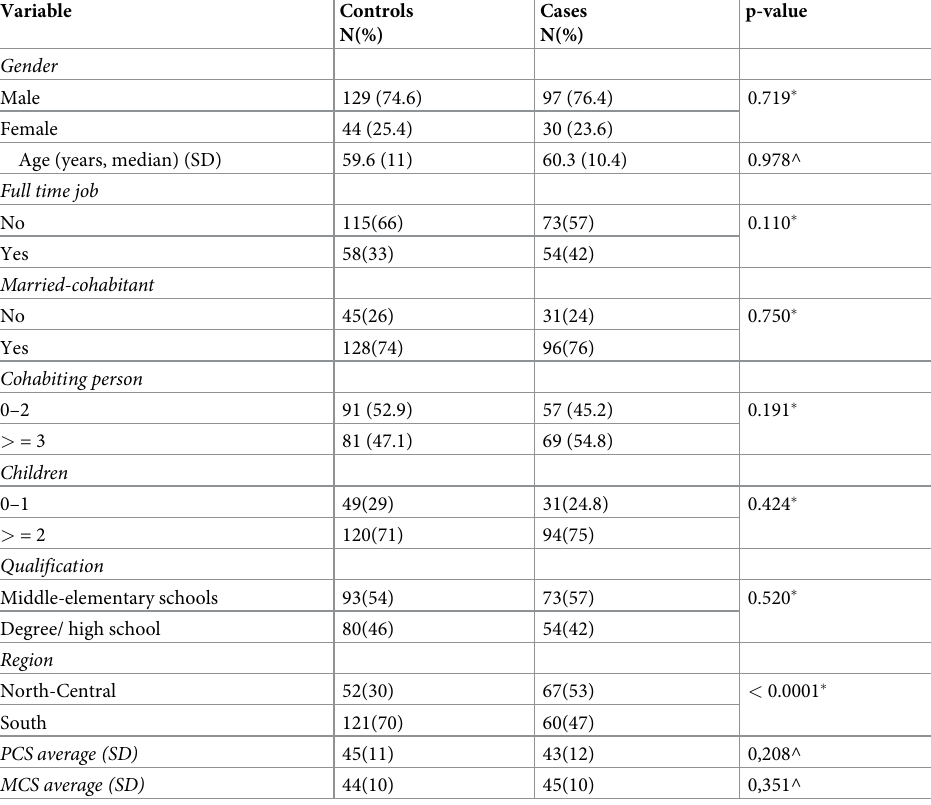
Table 1. Characteristics of cases and